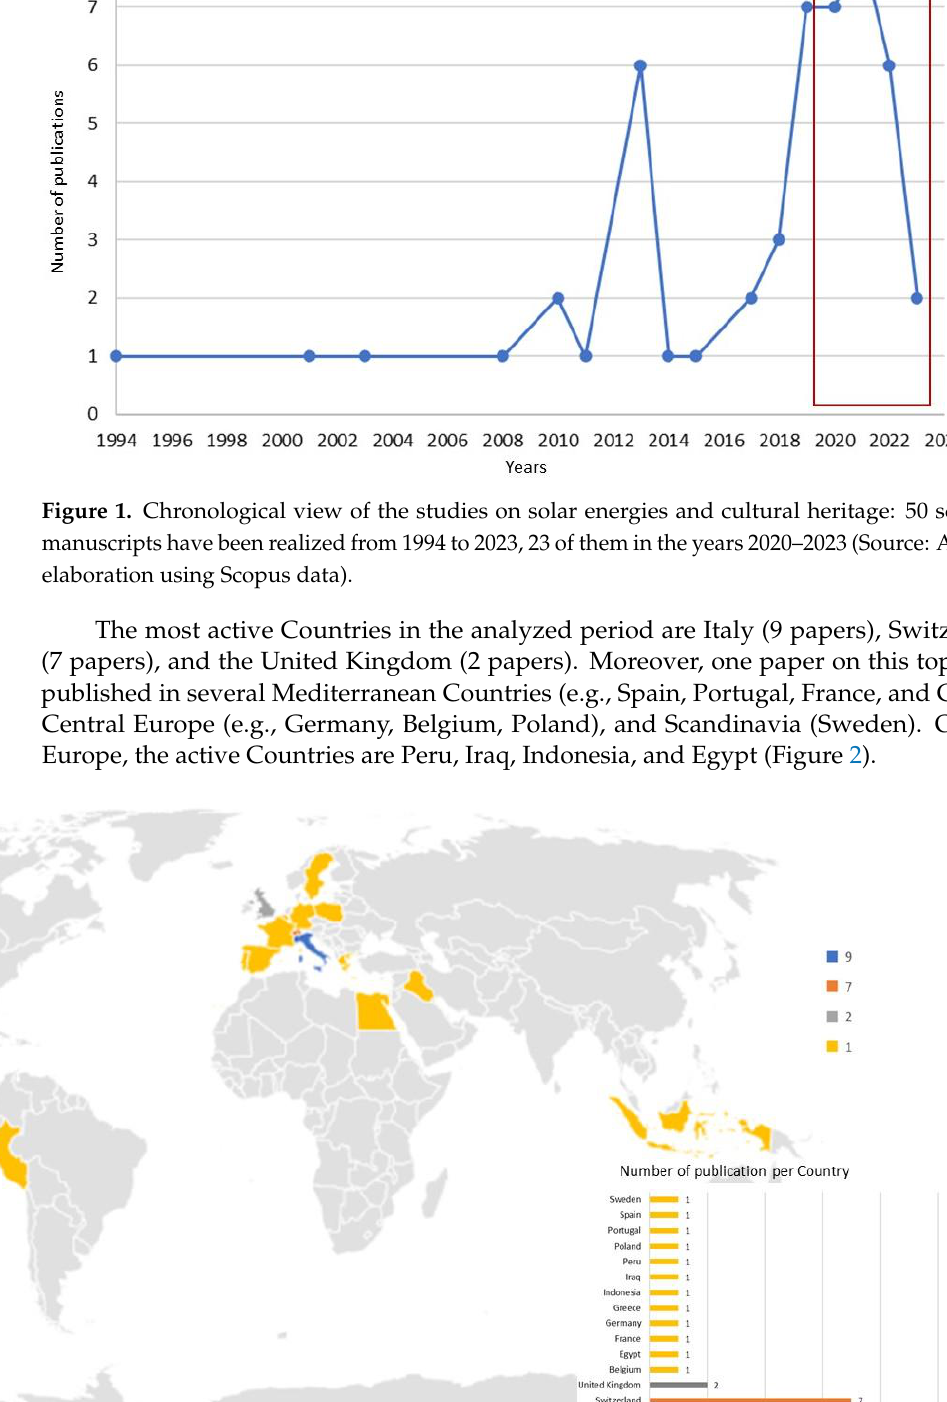
Figure 2. Map of scientific studies on solar energies and architectural heritage according to their provenience (Source: Author ’ s elaboration using Scopus data).